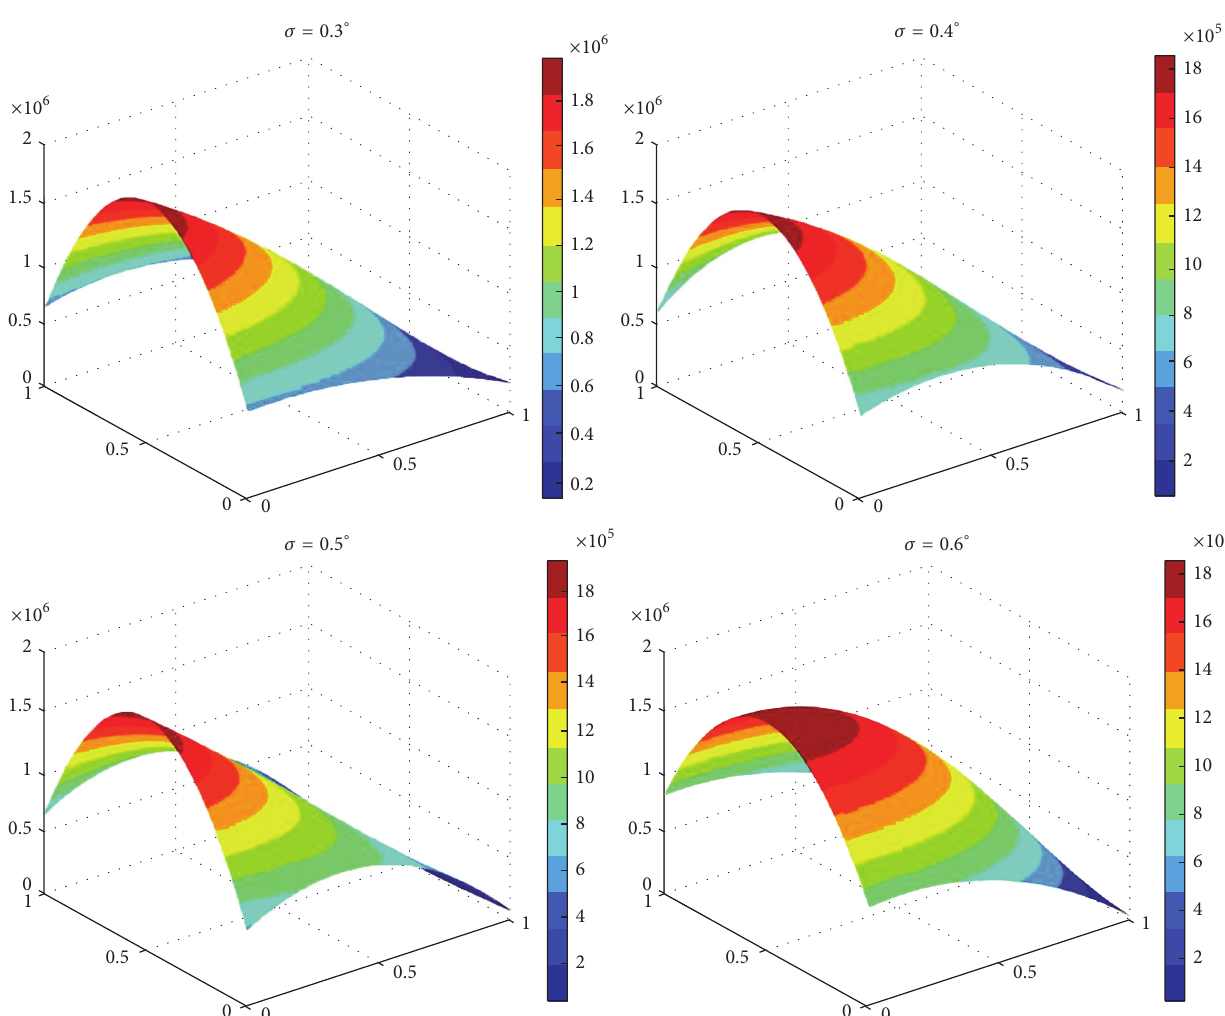
Figure 7: Flux distribution at deflection angles of 0.3 ∘ , 0.4 ∘ , 0.5 ∘ , and 0.6 ∘